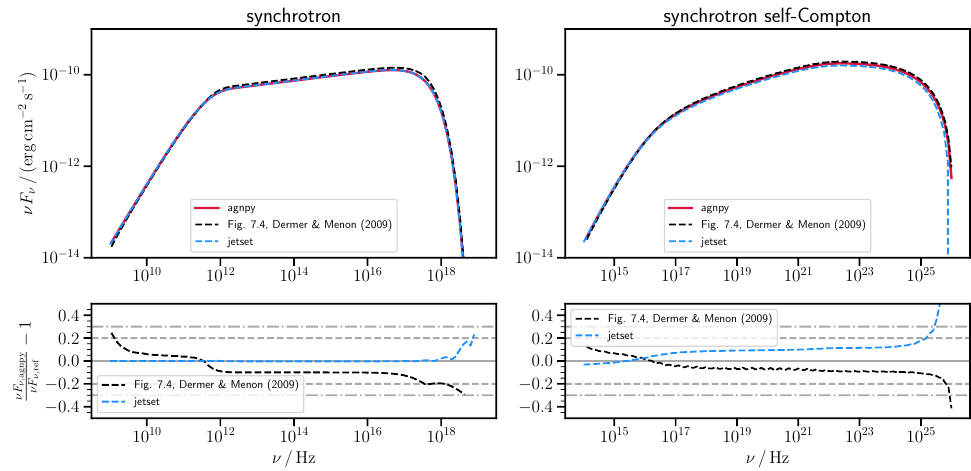
Figure 8. An example of validation: synchrotron and SSC SEDs generated with the same model parameters using agnpy and Jetset. Both spectra are compared against a result from the literature [7]. Figure from [78], reproduced with permission of Astronomy and